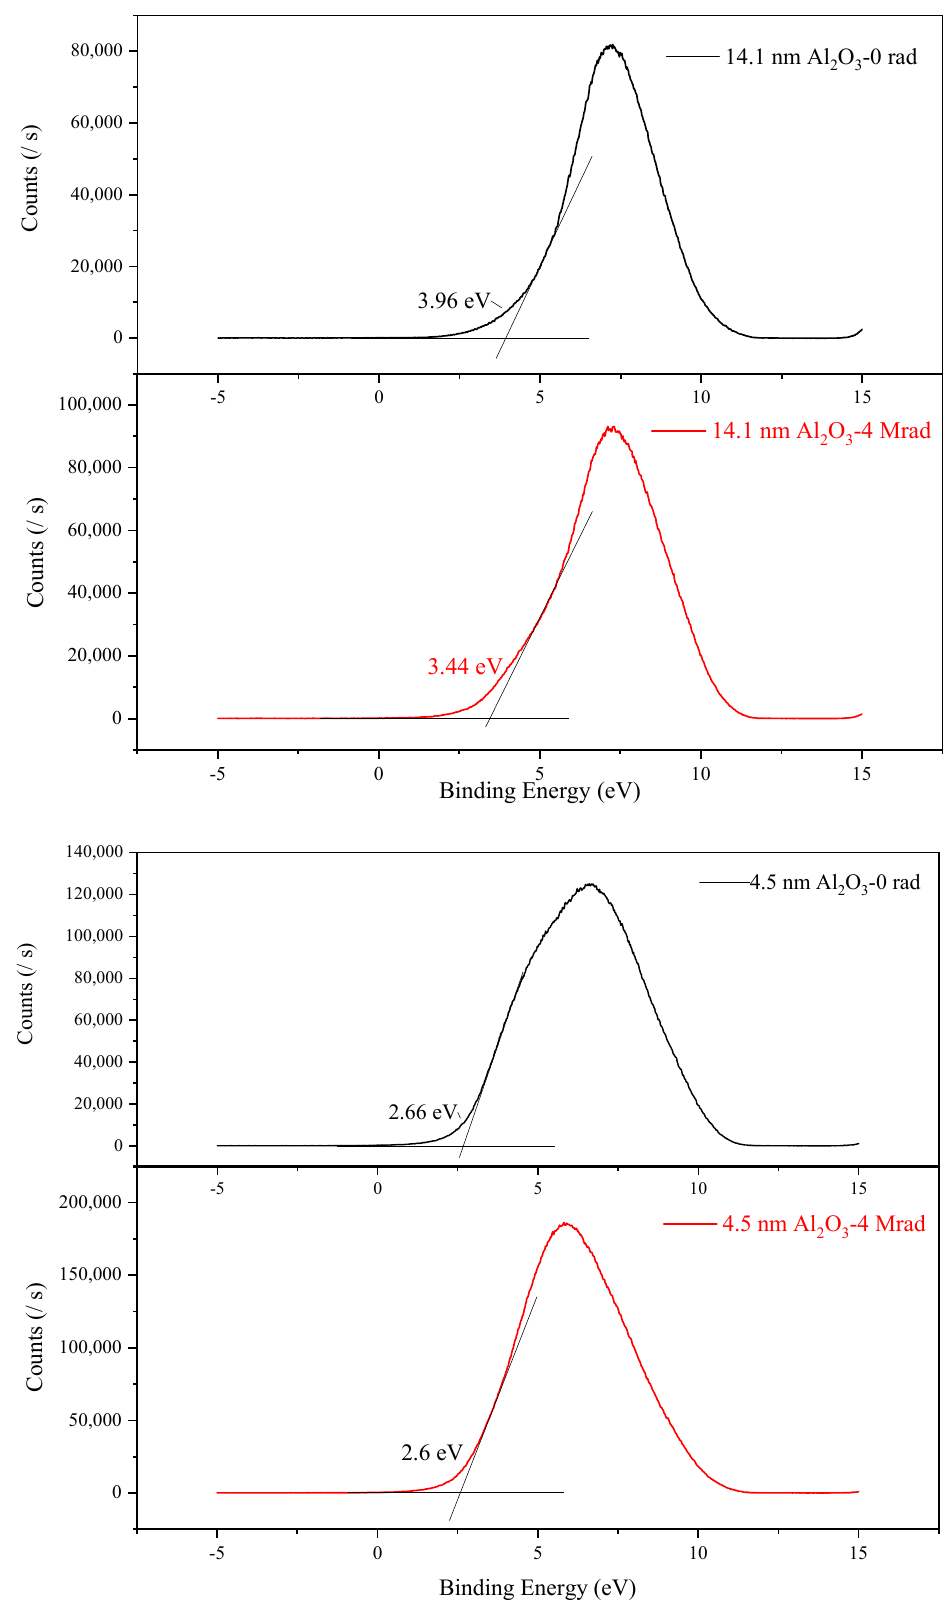
Figure 5. Valence band spectrum of Al 2 O 3 /Si structure taken by ultraviolet photoelectron spectroscopy (UPS).